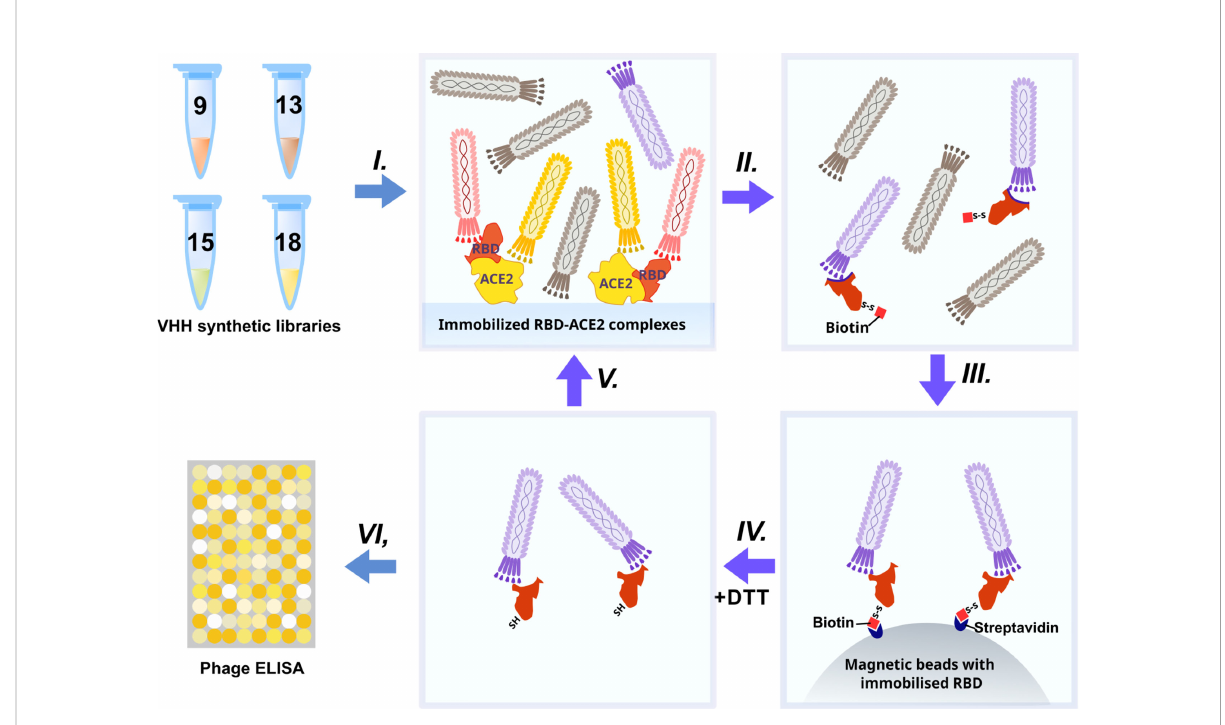
FIGURE 2 Schematic representation of RBD-binders phage display